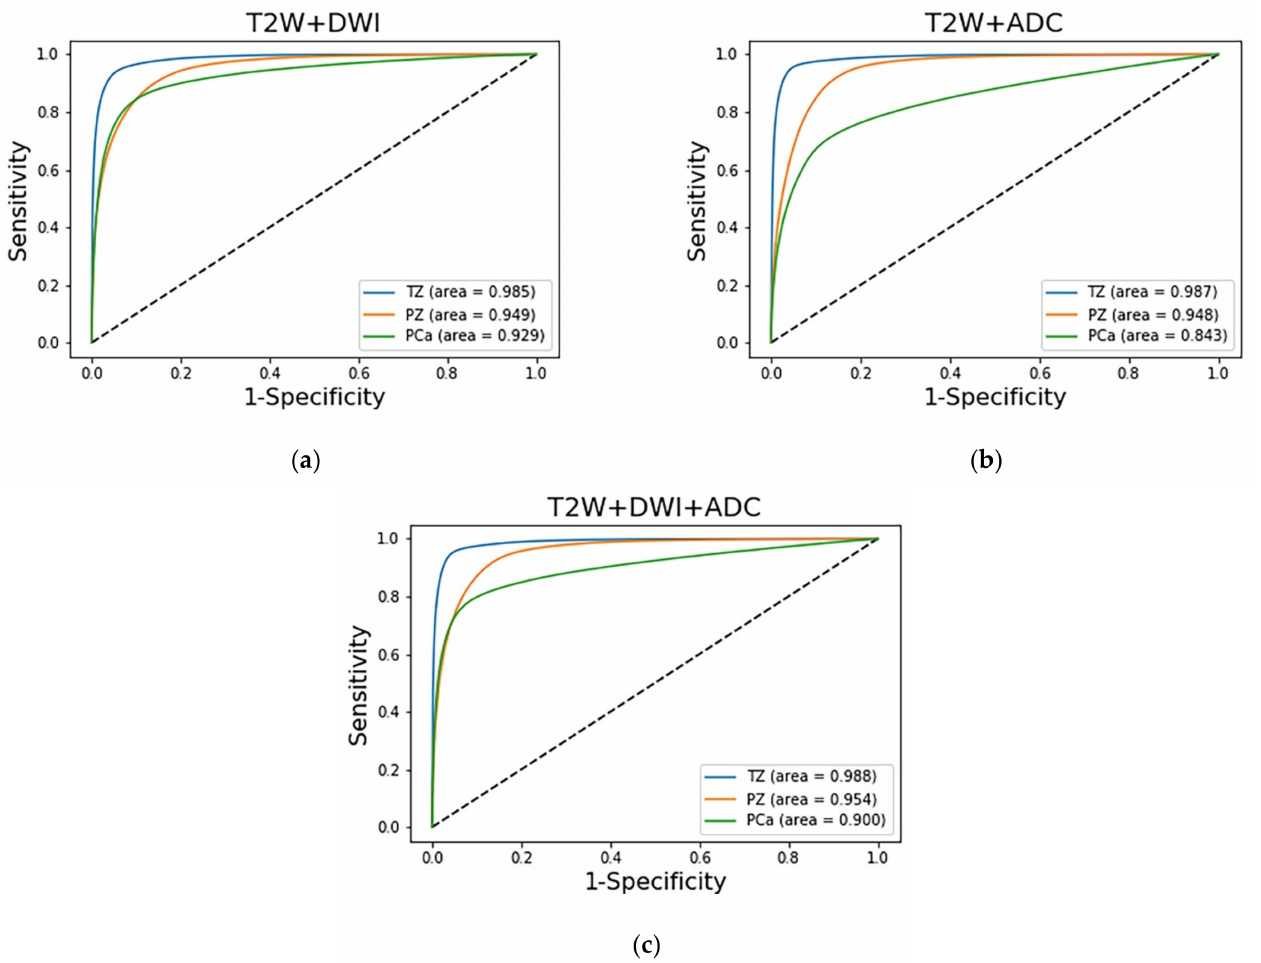
Figure 5. Comparison of the ROC curves of the three prediction models for discriminating among the TZ, PZ, and PCa region. The blue, orange, and green lines represent the predictions for the TZ, PZ, and PCa region, respectively. Different combination of the ( a ) T2W + DWI. ( b ) T2W + ADC. ( c ) T2W + DWI +